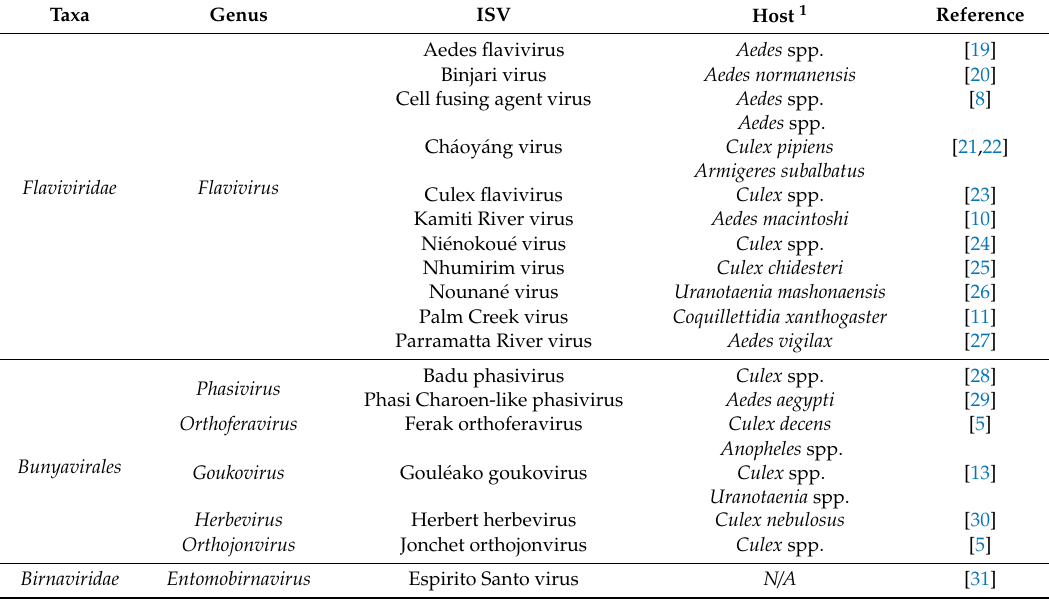
Table 1. Classification of the most relevant insect-specific viruses with confirmed mosquito vector